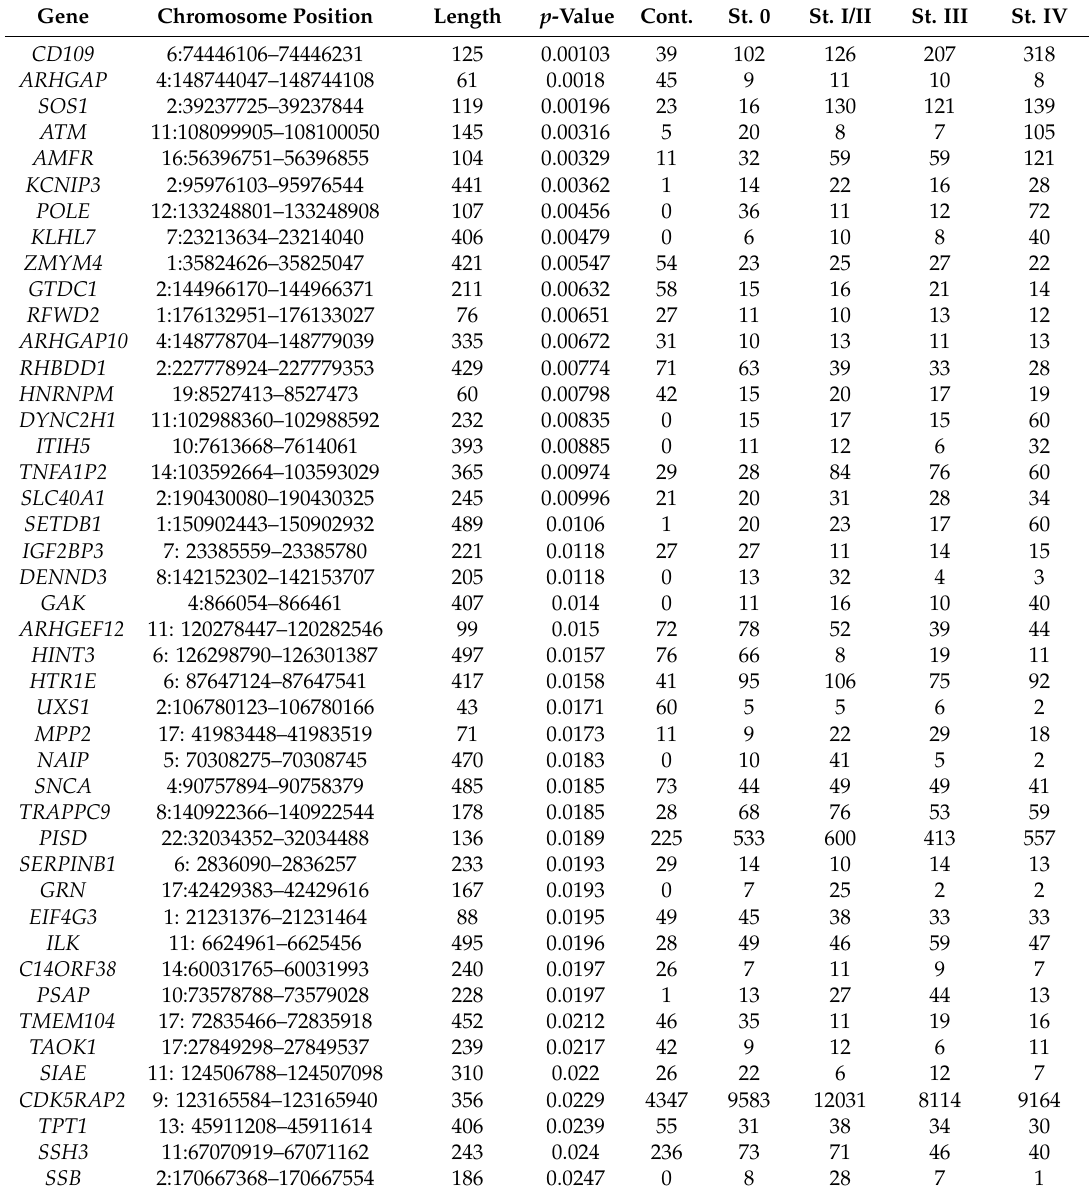
Table A1. Differentially expressed protein-encoding probe sets ( p < 0.05). Gene names and coordinates are given. Counts were normalized per million reads. mRNAs validated are depicted in